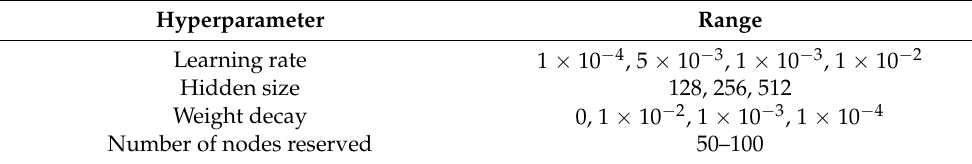
Table 2. The hyperparameters of our model and compared models. The hidden size is only for Graph Neural Network (GNN) models. The 0 value of Weight decay is used for the experiments on training set to show the expression ability of the GNN models. The number of nodes reserved is only for the model with